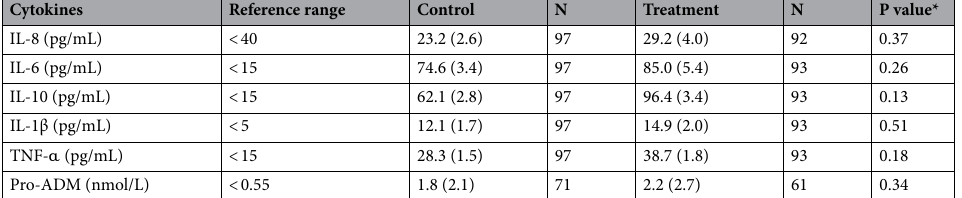
Table 3. Overall cytokines in the study groups during the study. Values are reported as geometric means and geometric standard deviations (in brackets). N Number of samples. *P value from random-effects linear regression models on log-transformed outcomes (cytokines), adjusted for basal value of dependent variable and time treated as a quantitative variable (i.e., we assigned values from 0 to 4 to the five